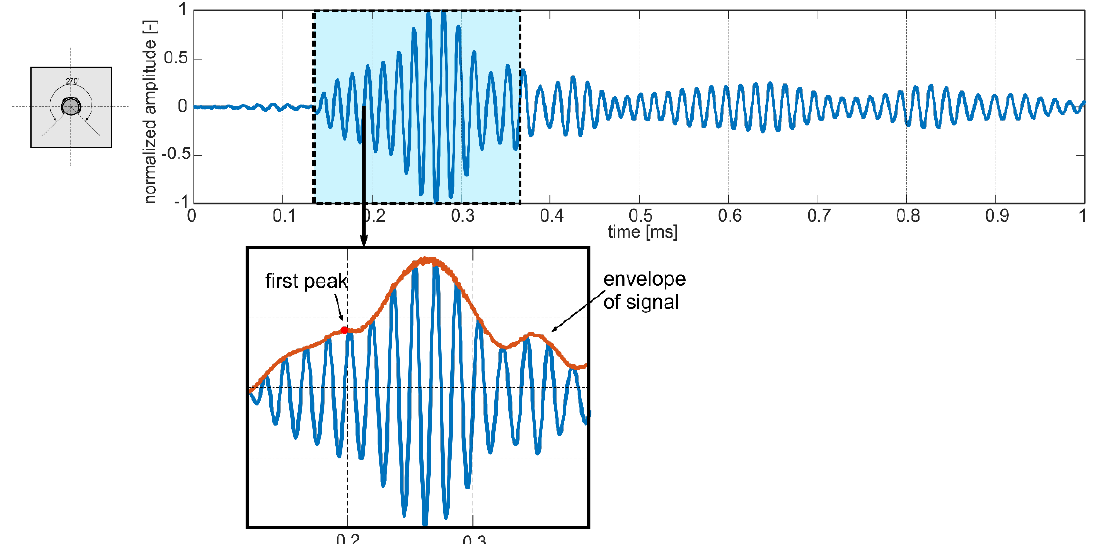
Figure 8. Initial part of the signal registered for the beam #D: determining the time of flight for overlapping wave packets.